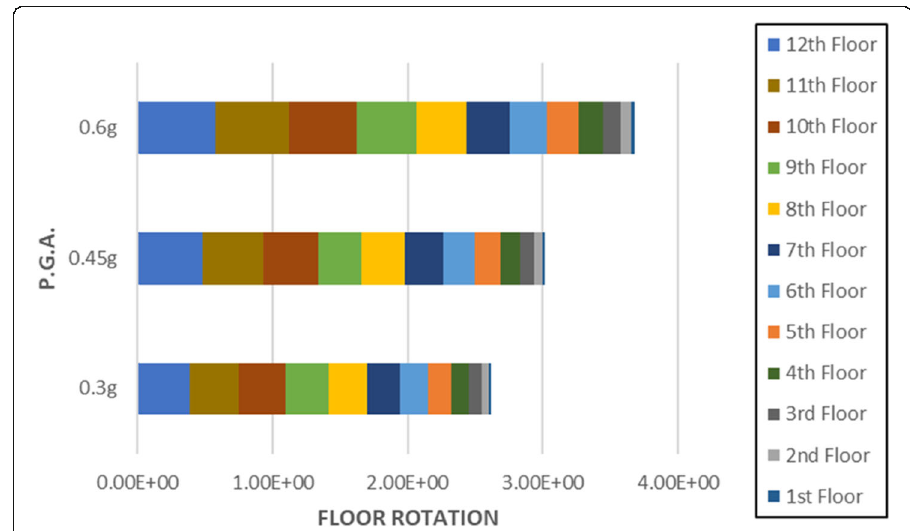
Fig. 31 Comparison of floor rotations — P.G.A. for (DS1-3, DS2-3, and DS3-3) (color should be used for this figure)